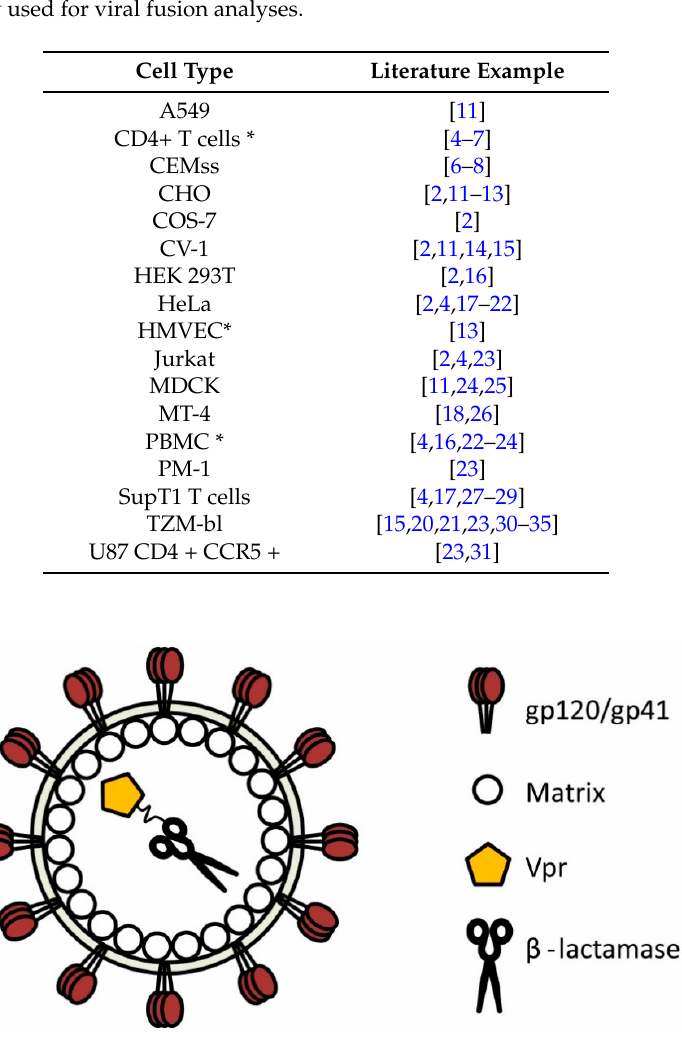
Figure 2. A representation of a HIV-1 particle is shown. β -lactamase can be packaged into nascent HIV-1 virions by fusing it to the accessory protein Vpr. For purposes of clarity, several HIV-1 proteins are not depicted.